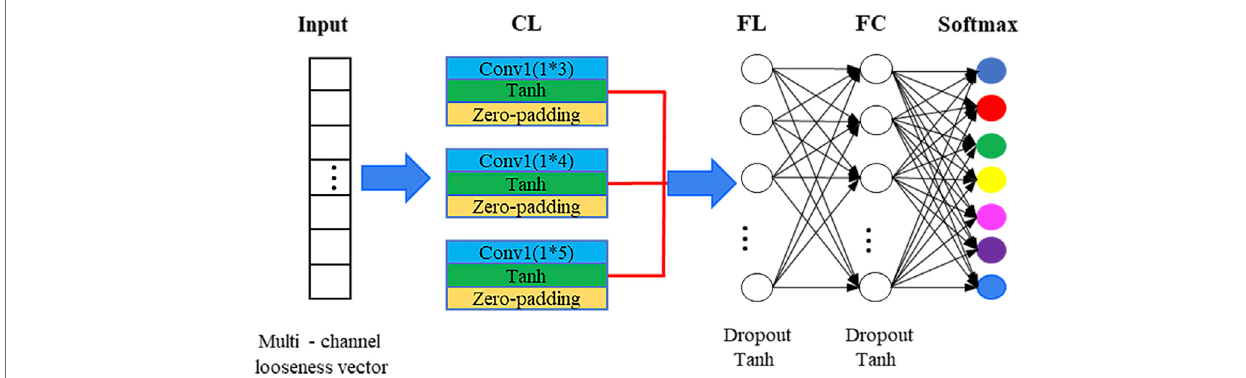
FIGURE 3 | Architecture diagram of the baseline 1DCNN model.